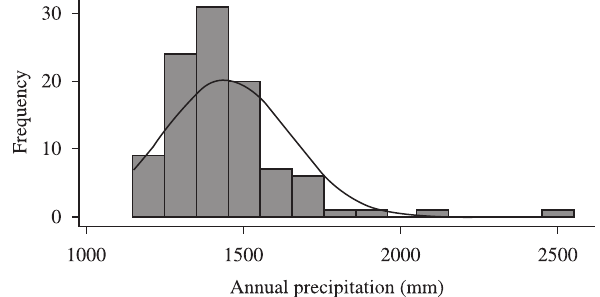
Figure 6. Absolute frequency histogram of the annual precipitations for the cities of São Paulo State.